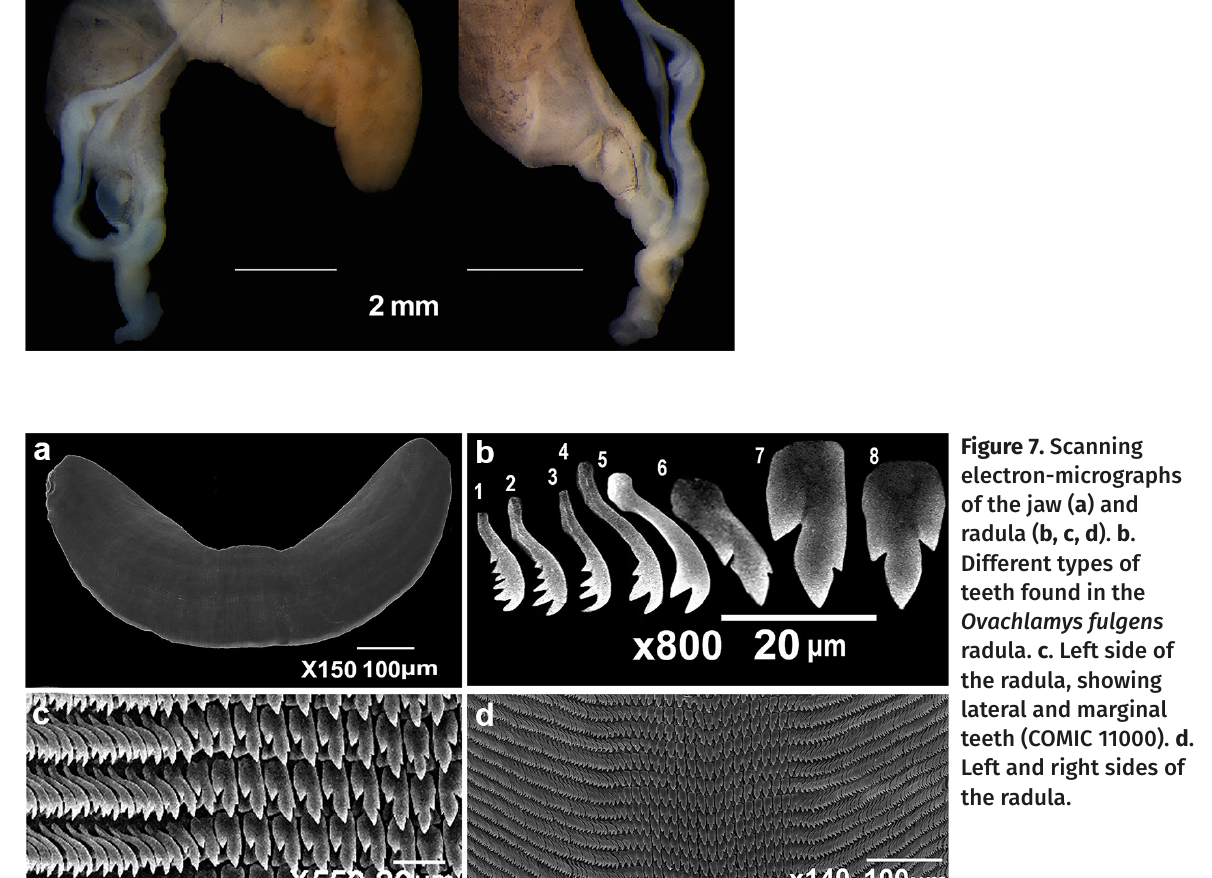
Figure 6. Drawing and photography of the complete reproductive system of Ovachlamys fulgens under stereomicroscope. a . Specimen from Petrópolis (CMIOC 10986). b . Specimen from Niterói (CMIOC 10.999). d-e . Specimen from Magé (CMIOC 10993). AL. Albumen gland; AT. Genital atrium; CA. Capsule gland; EP. Epiphalus; DU. Bursa copulatrix duct; HD. Hermadrodict duct (or ovulispermioduct); FA. Penis, and its expansion proximally located; SP. Oviduct; OV. Ovotestis (=gonad or hermafrodict gland). RM. Retractor muscle of the penis inserted on the lower part of the epiphallus; ST. Bursa copulatrix; VD. Vas deferens; VA. Short vagina; TA. Talon.